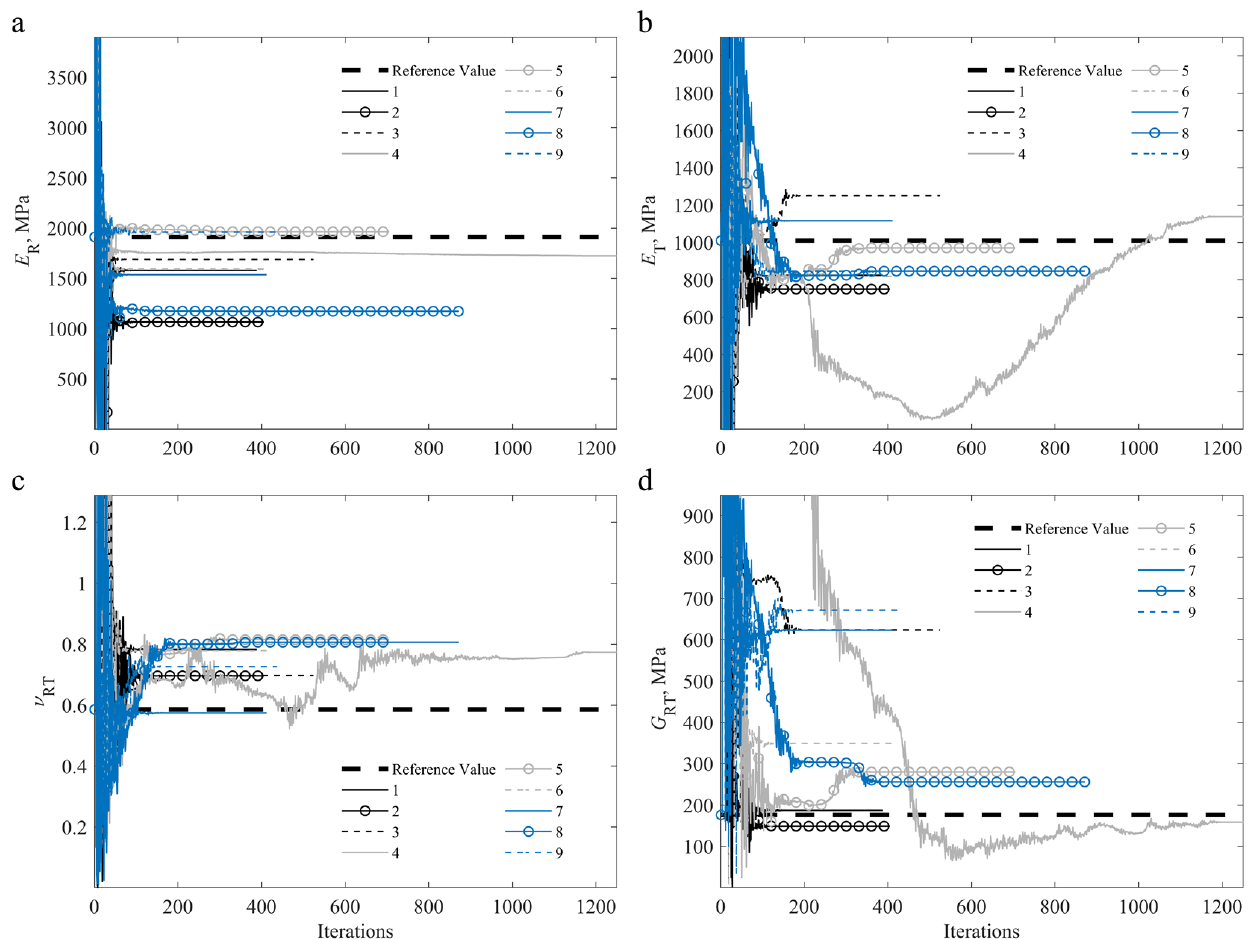
Figure 9. Convergence of the identified parameters for the on-axis (1–9) specimens during the iterative procedure, compared to the reference values [2,55]: ( a ) E R ; ( b ) E T ; ( c ) ν RT ; ( d ) G RT